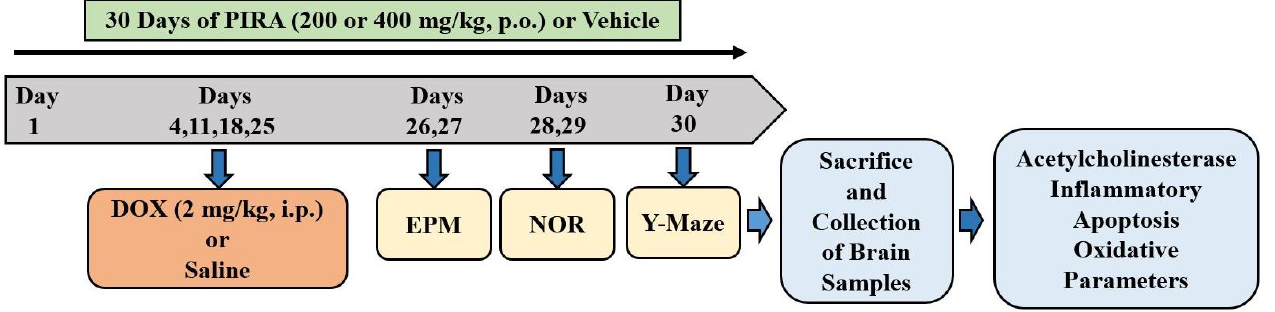
Figure 8. Timeline of the in vivo experiments. Four groups of rats were orally administered with the vehicle or piracetam (PIRA) for 30 days. Except for the control, all groups were injected with four doses of doxorubicin (DOX; 2 mg/kg, i.p.; days 4, 11, 18, and 25) to induce neurotoxicity. For the elevated plus maze (EPM) assessments, the training sessions were conducted on day 26, and retention assessments were analyzed on day 27. The novel object recognition (NOR) test was conducted on day 28 (habituation) and day 29 (training and test sessions), respectively. Both sessions (training and test sessions) of the Y-Maze test were conducted on day 30. At the end of the memory tests, on day 30, all the animals were sacrificed and brain tissues were collected for ELISA tests.